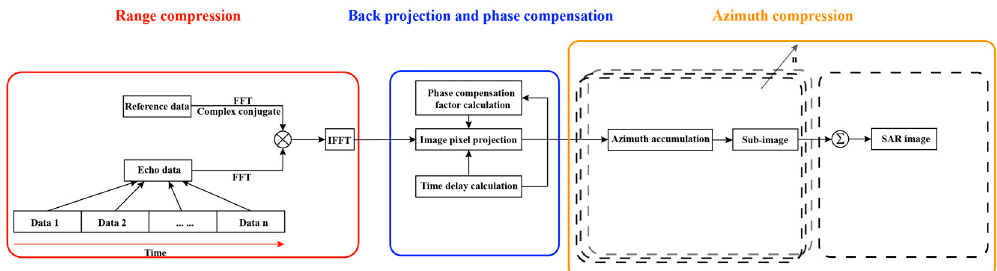
Figure 3. A block diagram of the improved BPA.